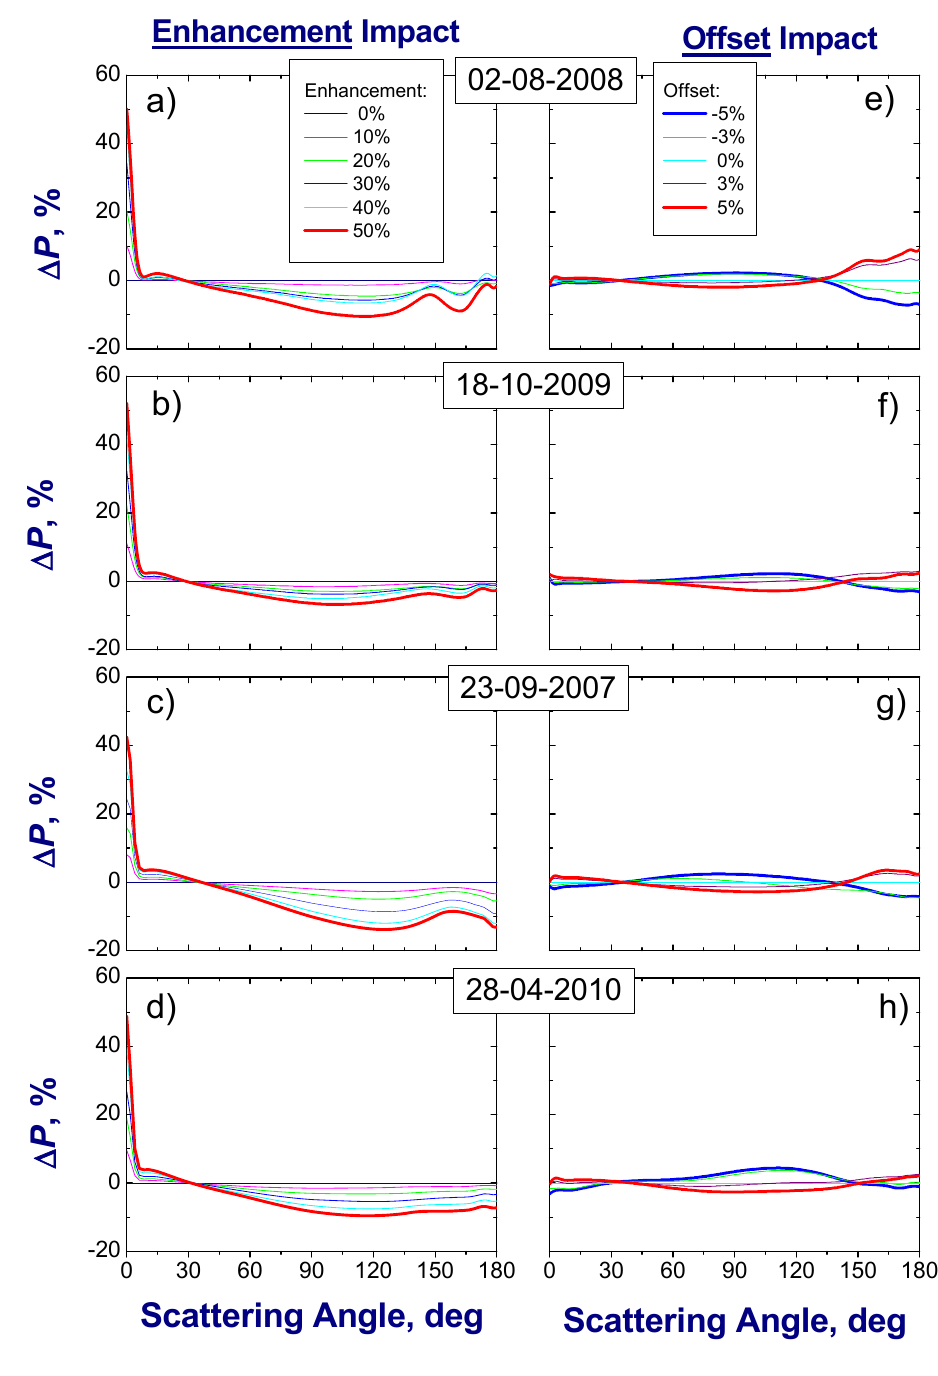
Figure 7. The same as Figure 5, except that these differences correspond to the scattering phase function ( P ) at 0.44 μ m